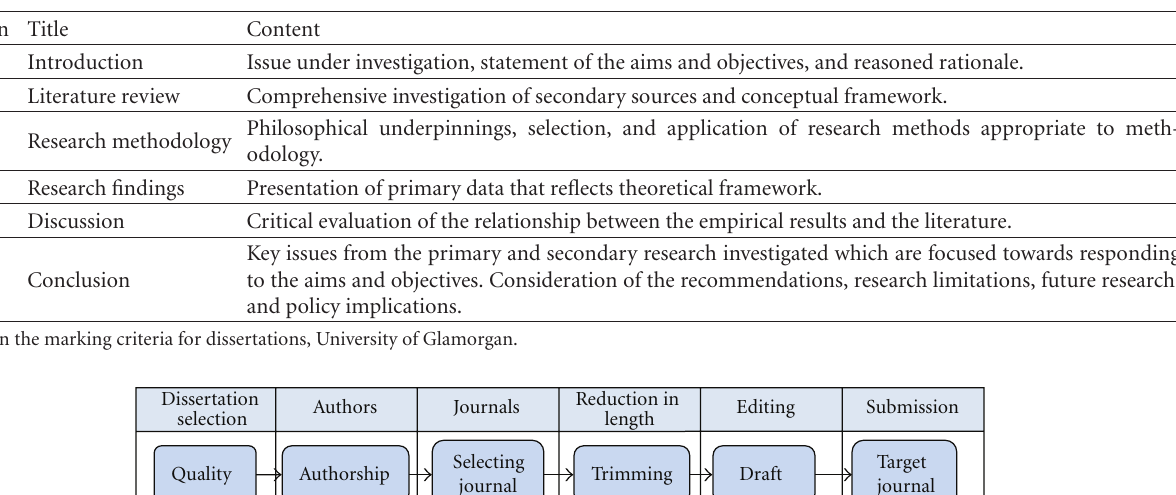
Table 2: Criteria for developing a dissertation into a journal paper.